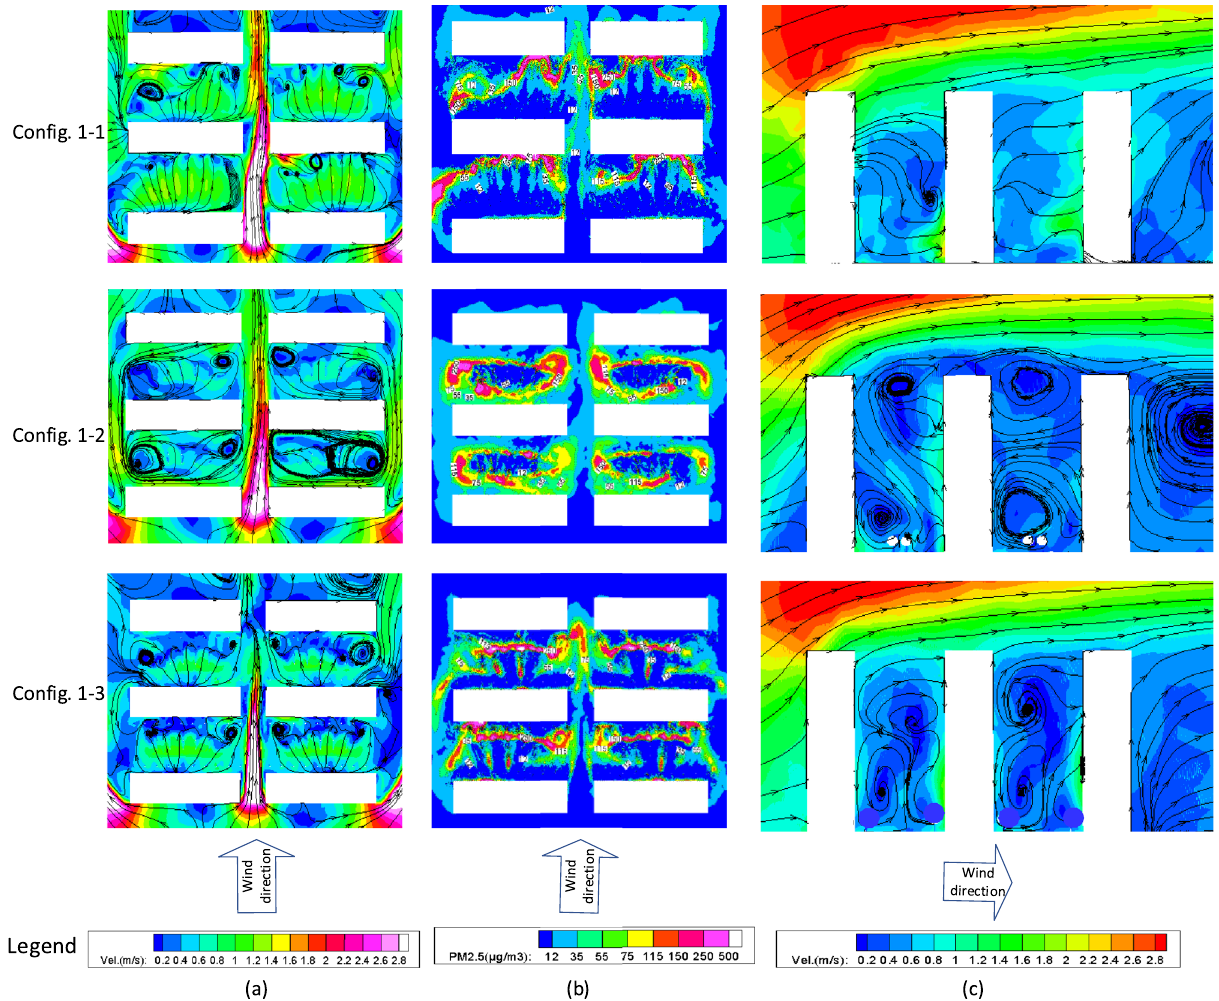
Figure 5. Plan view of the ( a ) wind velocity; ( b ) PM 2.5 concentration at pedestrian height, and ( c ) lateral view of the wind velocity for